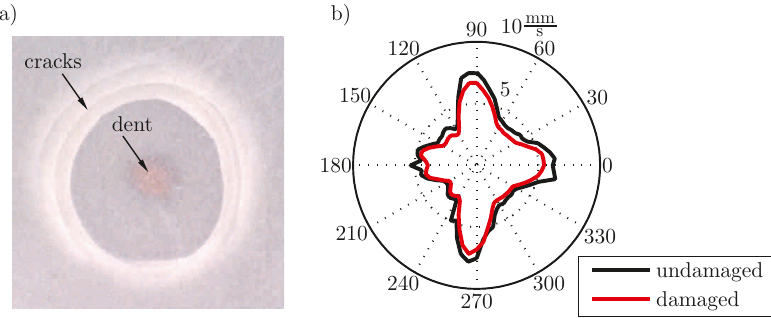
Figure 4. ( a ) Micrograph of the damage after grinding the upper surface of the piezoelectric wafer active sensors (PWAS); ( b ) Polar plot of the maximum out-of-plane velocity before and after the impact, measured at the